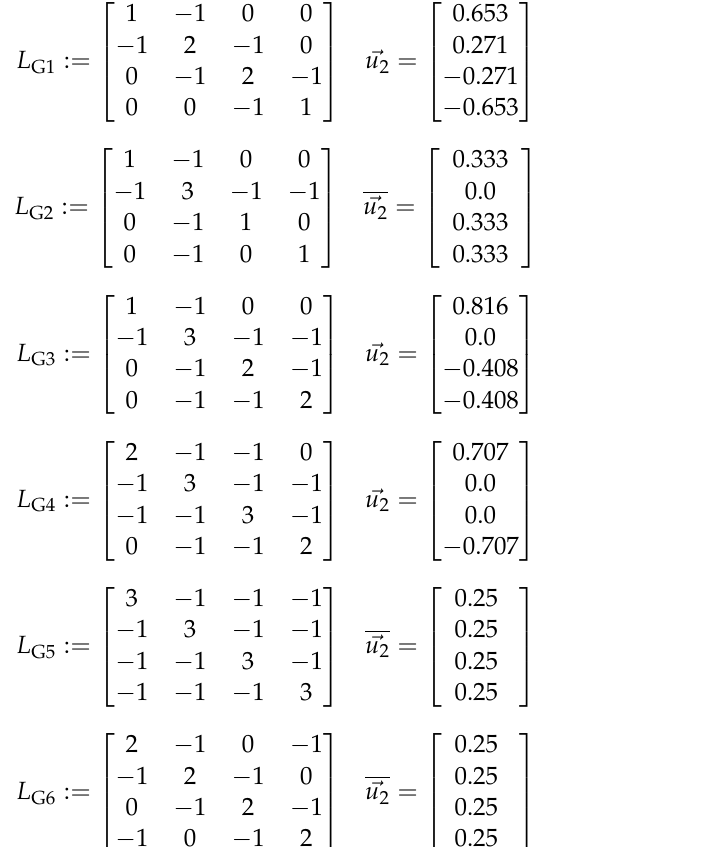
depict the voltage phase angle distribution. The operation U (cid:126) δ = ∆ (cid:126) δ computes the voltage phase angle difference between the network